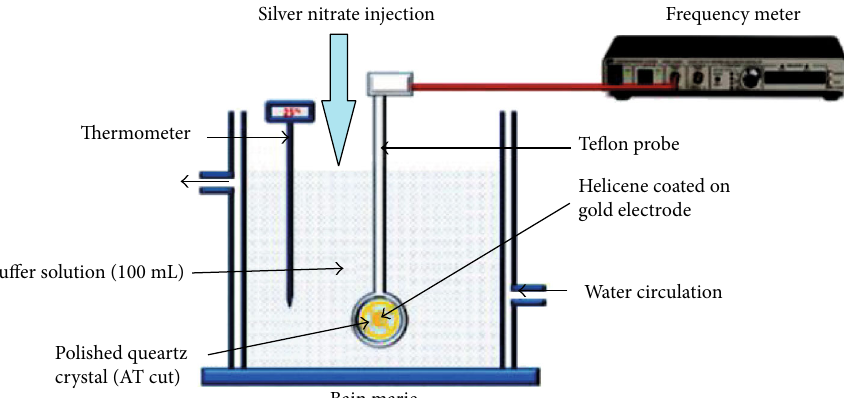
Figure 2: Experimental setup of the quartz crystal microbalance (QCM) devoted for the measurement of the experimental adsorption isotherms of silver nitrate on heptahelicene and